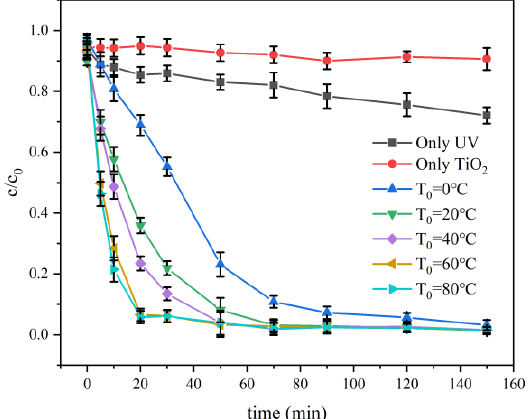
Figure 6. Evolution of the concentration of AR 26 at temperatures of wastewater at the bottom of the reactor of 0, 20, 40, 60, and 80 °C.